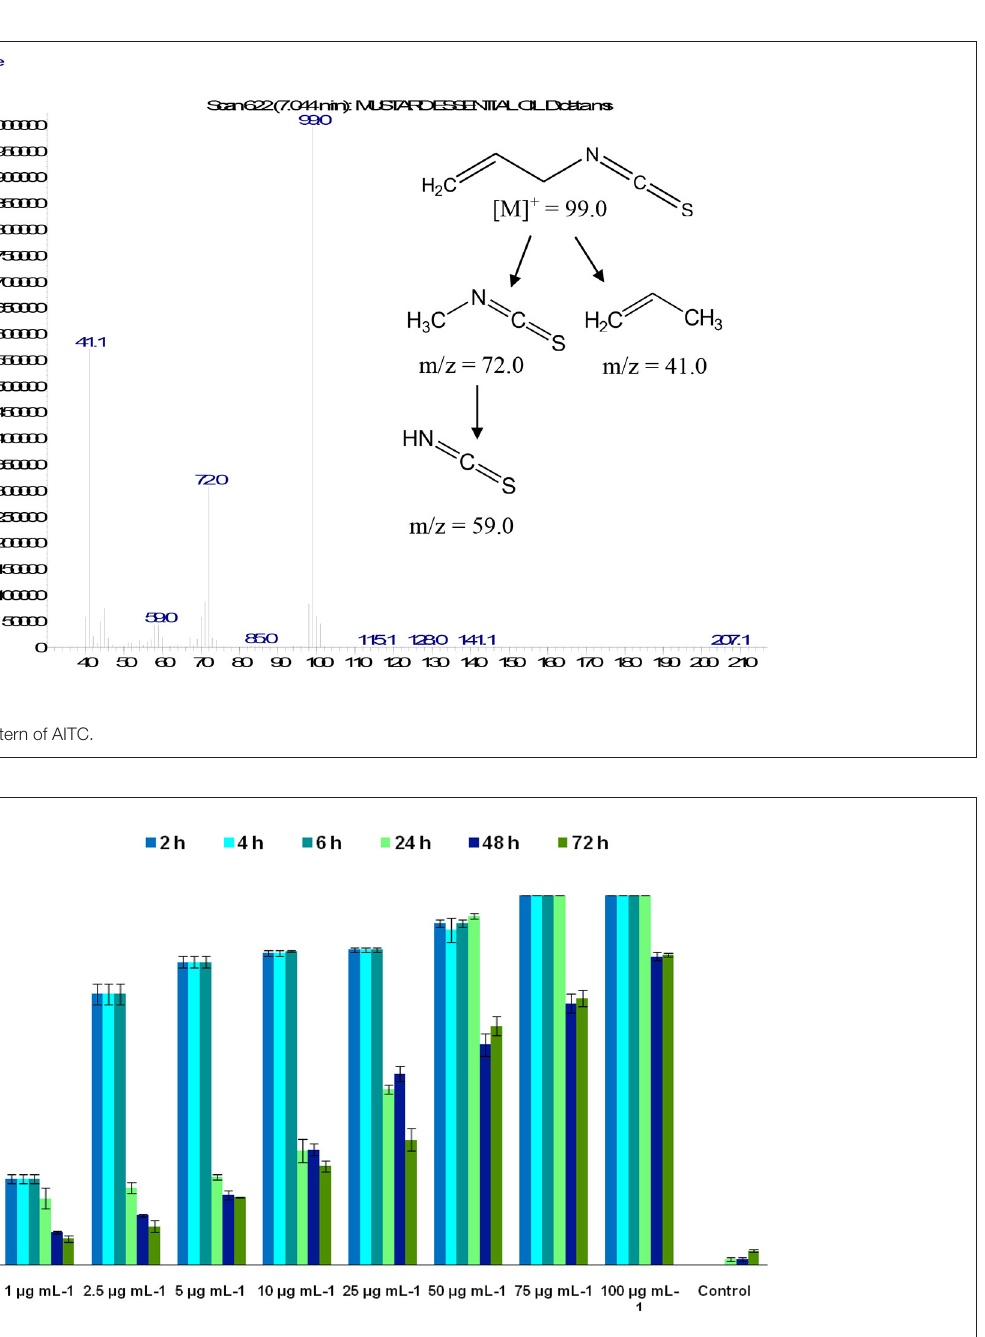
of MEO in juveniles clearly exhibited an inverse